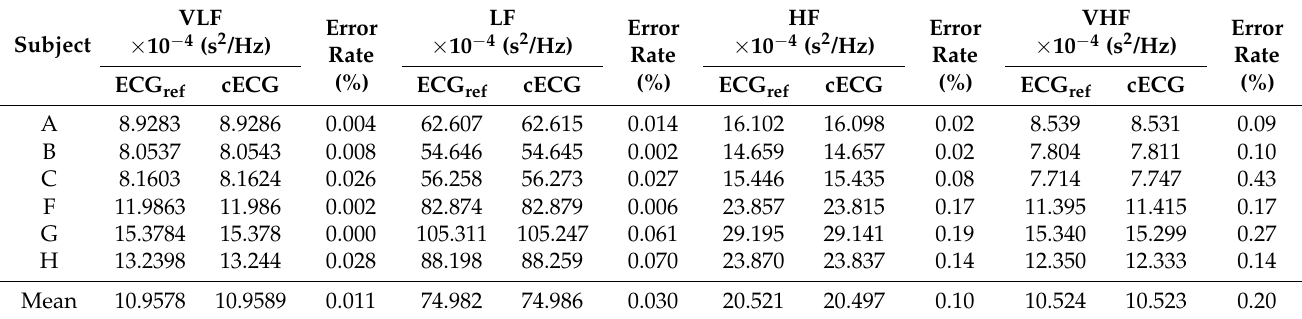
Table 3. Comparison of spectra of spectral power density (PSD) of heart rate variability (HRV) between ECG ref and